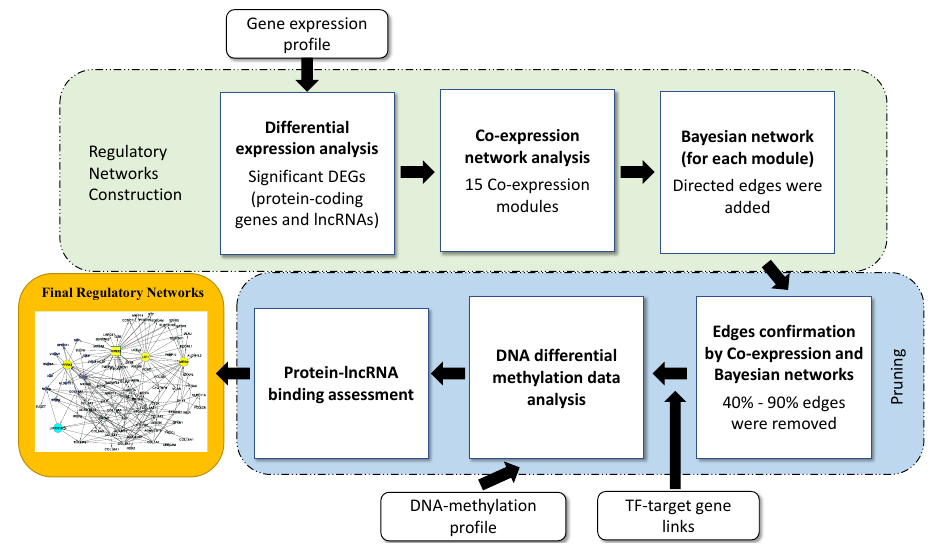
Figure 1. Gene regulatory network identification procedure. The procedure includes co-expression identification, edge determination by transcription factor (TF) targets, Bayesian analysis, and long non-coding RNAs (lncRNA)–protein binding potential. The DNA methylation analysis was used to infer potential epigenetic regulations. DEGs: Differential Expressed